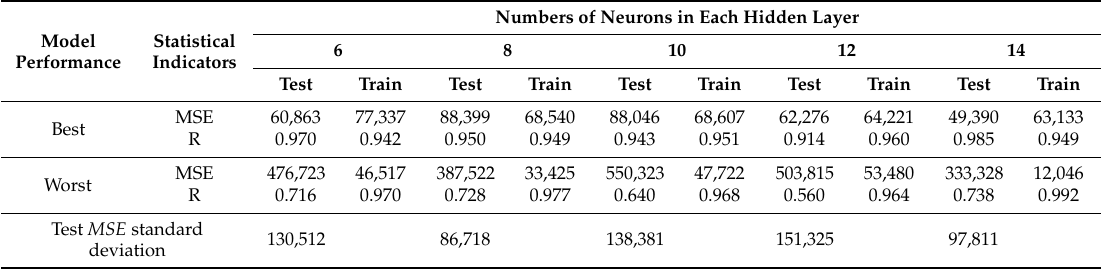
Table 7. E ff ect of data sample variability on the sti ff ness modulus model’s performance.